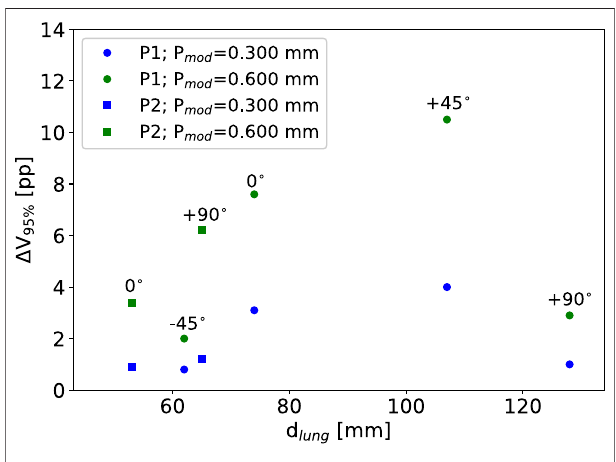
FIGURE 8 | The difference in target coverage between the non- modulateddosesandthedosescalculatedwith P mod (cid:1) 0.300 mm(blueplots) and P mod (cid:1) 0.600 mm (green plots) as a function of the amount of lung traversed by the particle beam (see Table 1 ). Circles mark data for P1, squares mark data for P2. For the P mod (cid:1) 0.600 mm plots the matching fi eld angles are shown. All plans are for carbon ions.